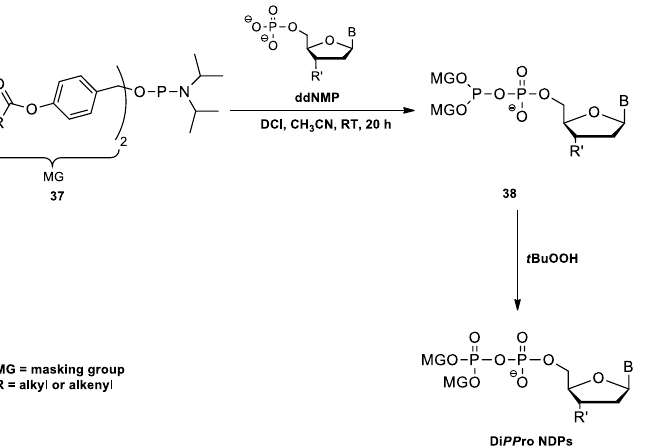
Figure 7. Structures of the developed pronucleotides of Di PP ro type